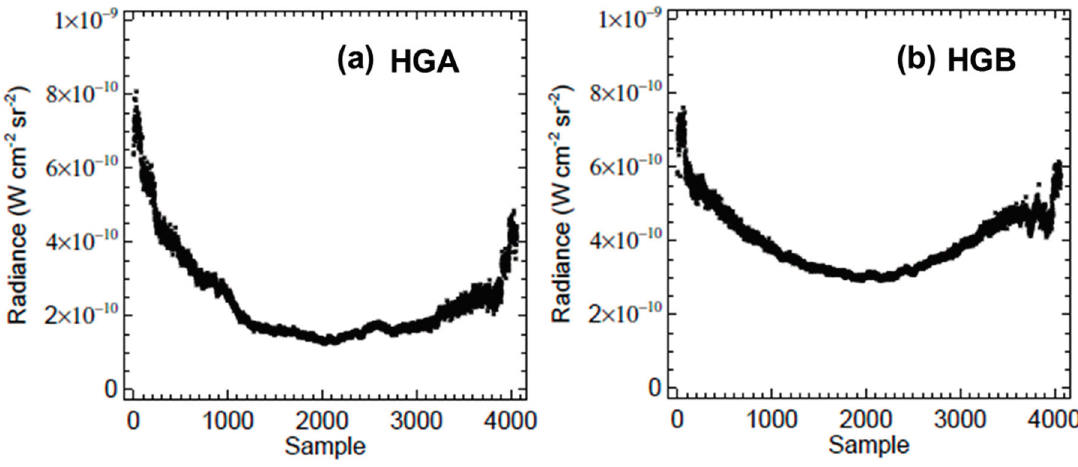
Figure 4. The radiance difference between the pitch maneuver deep space view (performed on 20 February 2012) and the VROP702 (VIIRS recommended operating procedure) dark ocean view (performed on 21 February 2012). ( a ) VROP702 HGA-pitch HGS; ( b ) VROP702 HGB-pitch HGS. Plots show detector averaged biases; the detector dependent airglow intensity could be higher or